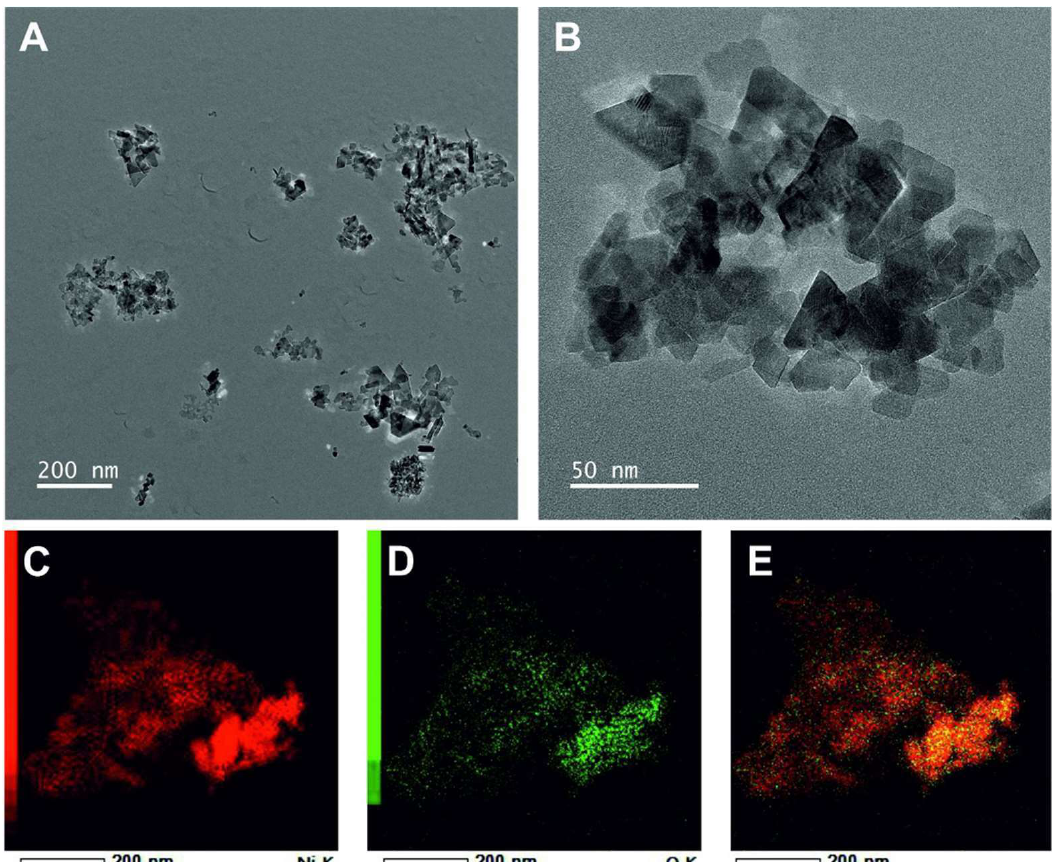
Figure 2. Analysis of nanoparticles and dot-mapping of nickel oxide by transmission electron microscopy (TEM). The upper panel presents the morphology of nickel ( A , B ). The lower panel shows the dot mapping of nickel and oxygen ( C – E ). Dot-mapping of nickel ( C ). Dot-mapping of nickel oxide ( D ). The merged representation of nickel and oxygen ( E ). This panel shows the oxygen distribution on the surface of nickel oxide